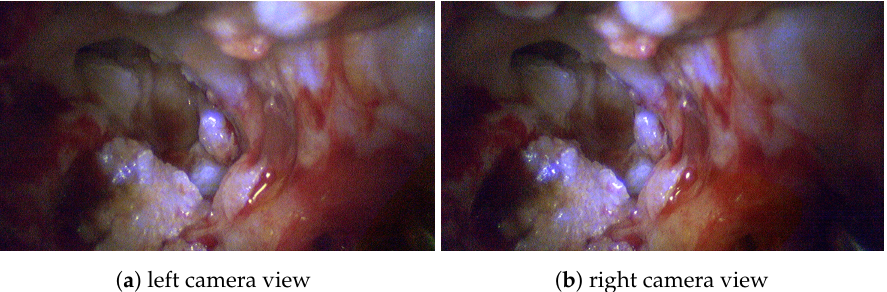
Figure 12. Stereo-spectral image pair with highlighted cholesteatoma